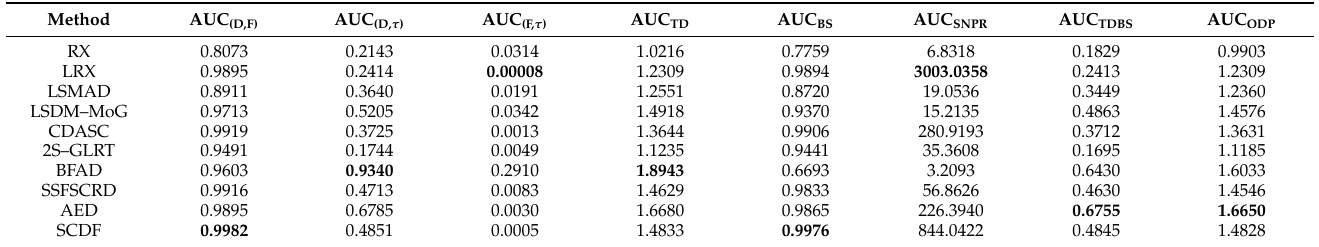
Figure 15. The 3D ROC curve and corresponding 2D ROC curves of different methods on the Chikusei dataset: ( a ) 3D ROC curve; ( b ) corresponding 2D ROC curve (P D , P F ); ( c ) corresponding 2D ROC curve (P D , τ ); ( d ) corresponding 2D ROC curve (P F , τ ). Table 2. Comparison of AUC performance of different methods on the synthetic dataset. Table 5. Comparison of AUC performance of different methods on the Chikusei dataset.